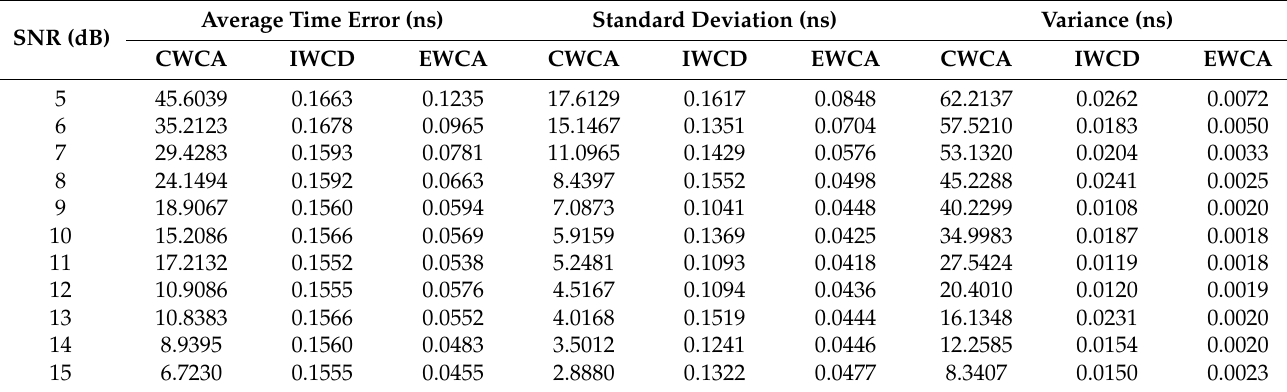
Table 1. The timing performance of the three algorithms under different